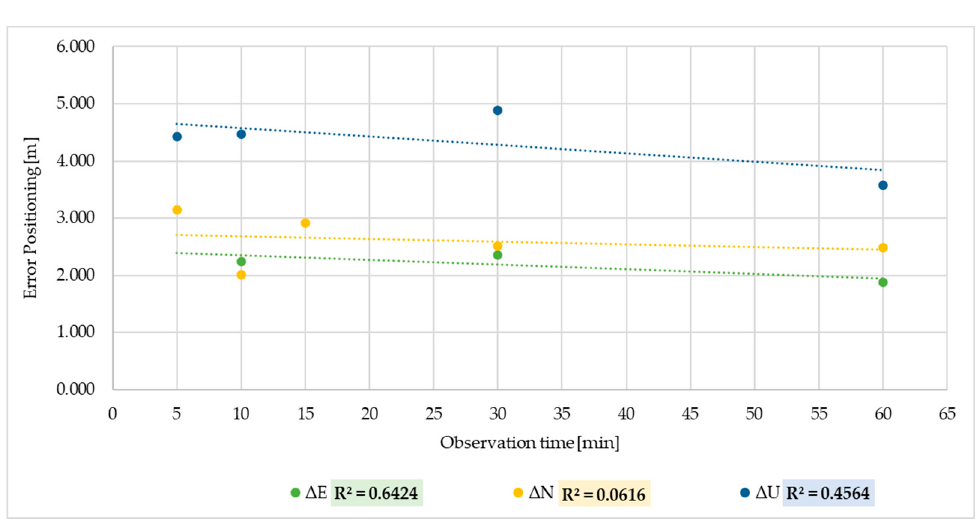
Table 9. Mean of Easting, Northing and Up DGNSS positioning errors for Δ E Km , Δ N Km , Δ U Km .